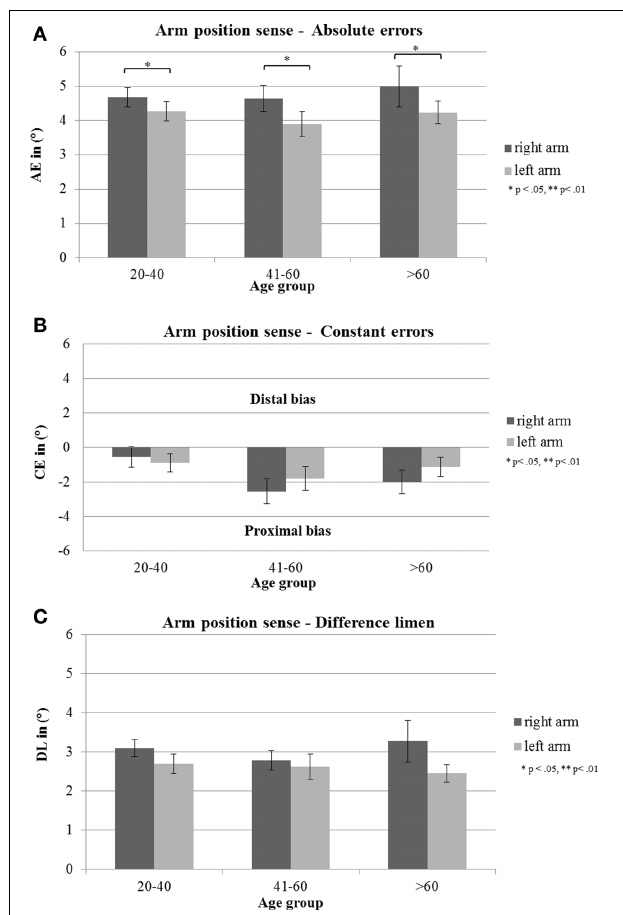
FIGURE 3 | (A) Mean absolute errors (AE; in degrees), (B) mean constant errors (CE; in degrees) and (C) mean difference threshold (difference limen, DL, in degrees) with standard error of the mean (s.e.m) of the three age groups of right and left arm. Negative errors indicate proximal deviations (toward the own body), positive errors distal deviations (away from the own